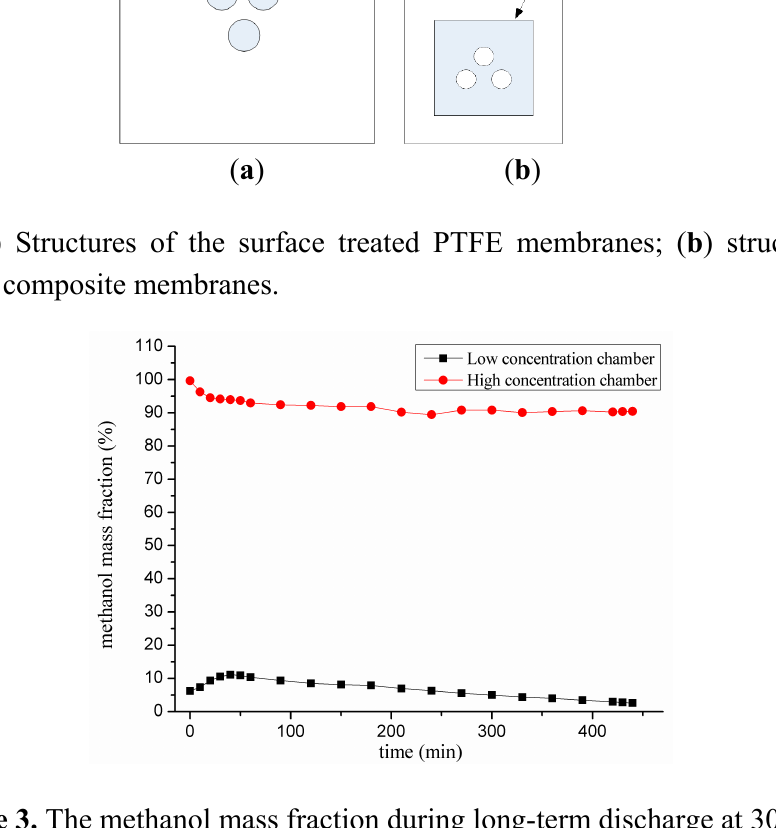
Figure 3. The methanol mass fraction during long-term discharge at 30